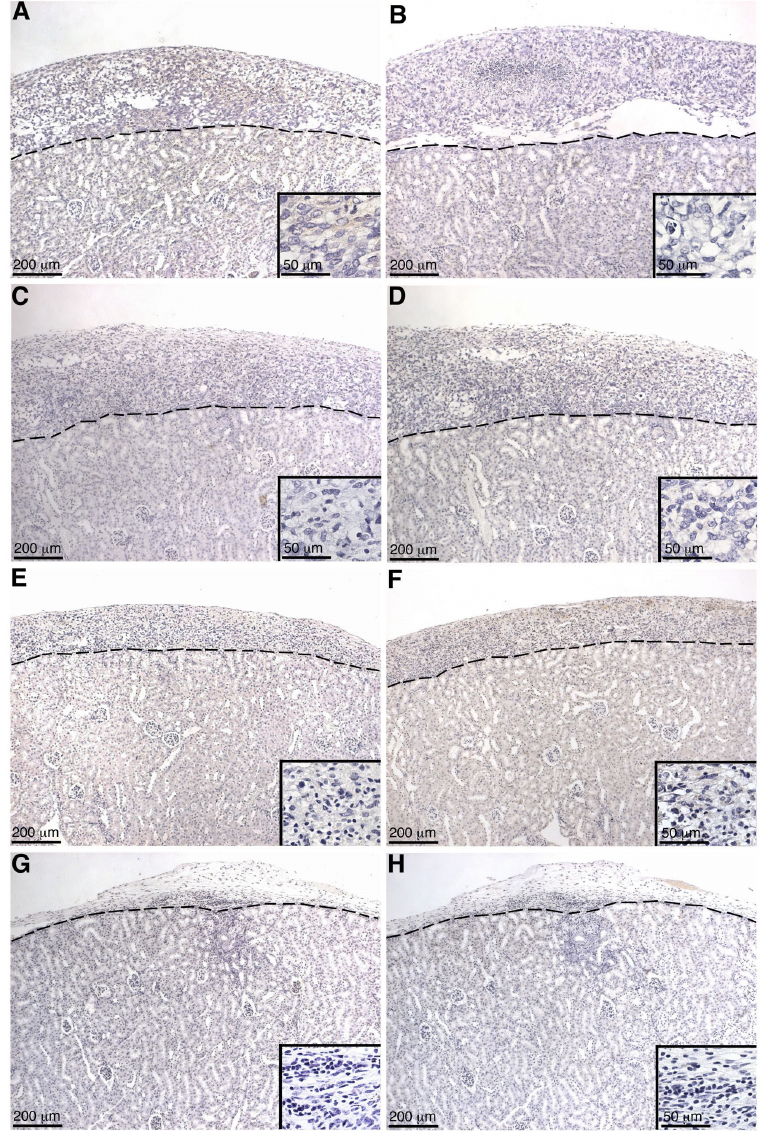
Figure 8. Immunohistochemical analysis of MSC-1 grafts for C4 and MAC deposition. Graft-bearing kidneys were collected at days 2 ( A , B ), 5 ( C , D ), 14 ( E , F ), and 20 ( G , H ) days post transplantation and tissue sections were immunostained for C4 (brown; A , C , E , G ) or MAC (brown; B , D , F , H ). Insets are higher magnifications. A dotted line separates the graft (above the line) from the kidney (below the line). Sections were counterstained with hematoxylin